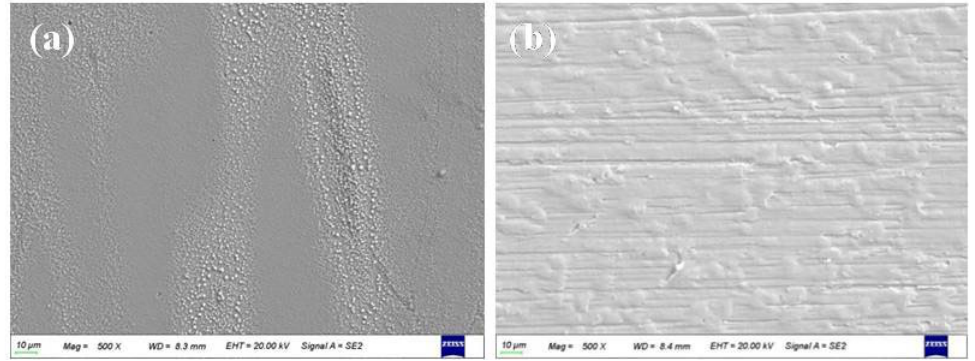
Figure 8. Microstructure after corrosion in a 360 °C high-temperature and high-pressure water environment for 14 days: ( a ) (FeNi)67Cr15Mn10Al5Ti3 alloy; ( b ) Zr-4 alloy.